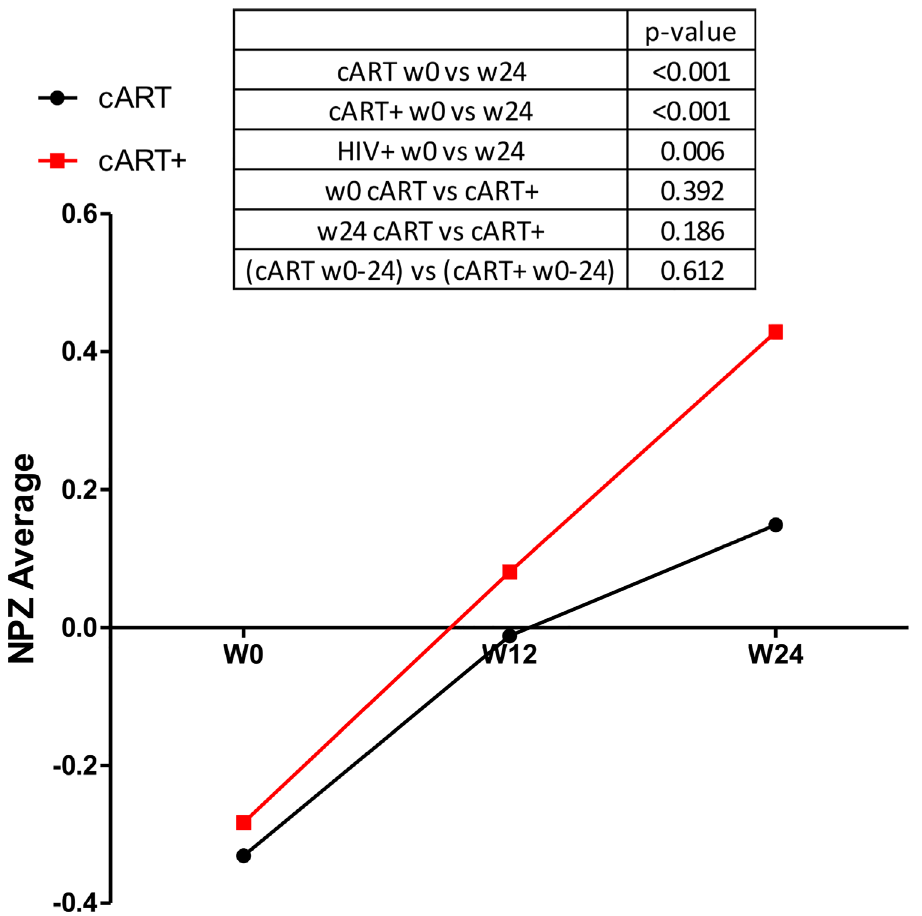
Fig 1. Change in neuropsychological testing performance (NPZ-4) over 24 weeks by randomized arm. Participants demonstrate improvement with no differences noted by arm.